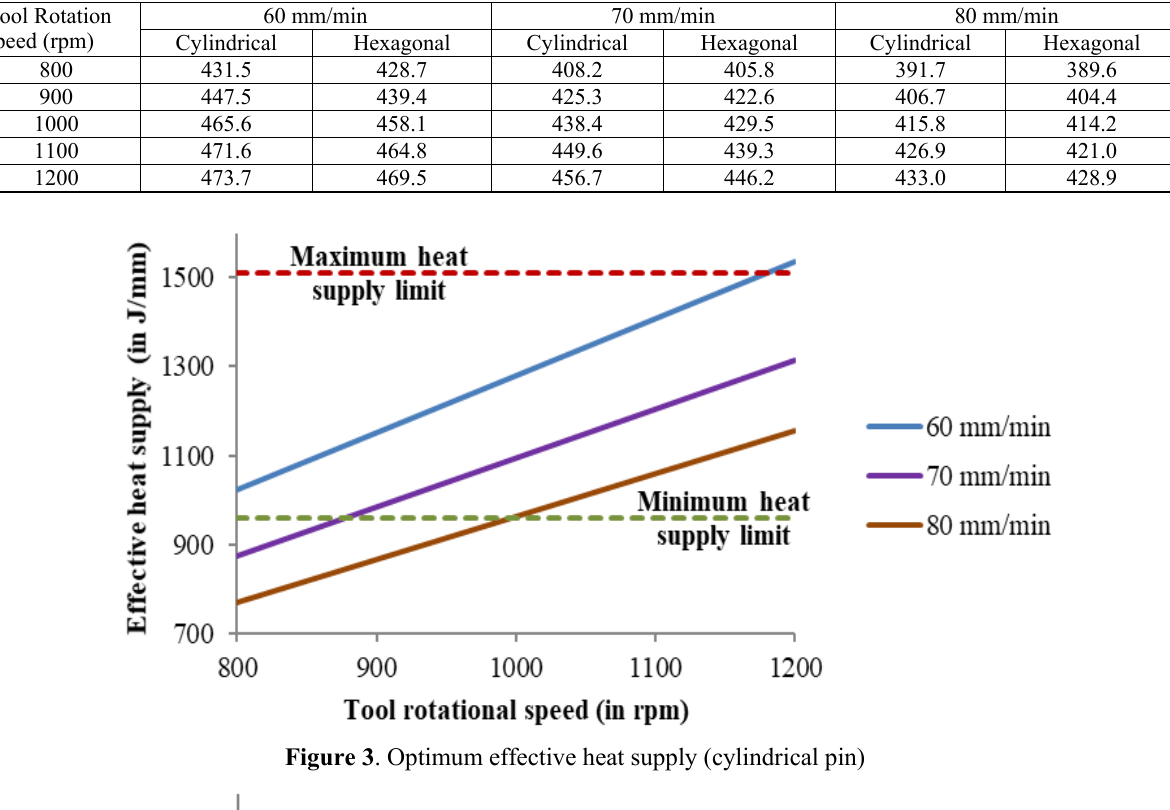
Table 3. Peak process temperature during the welding stage (in °C)